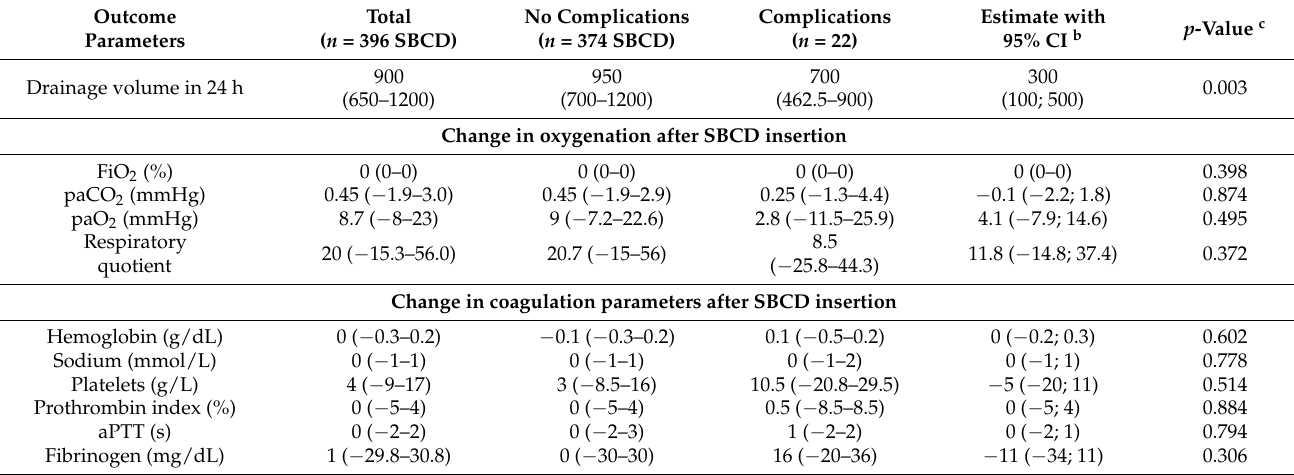
Table 3. Outcome parameters a per case ( n = 396 SBCD).